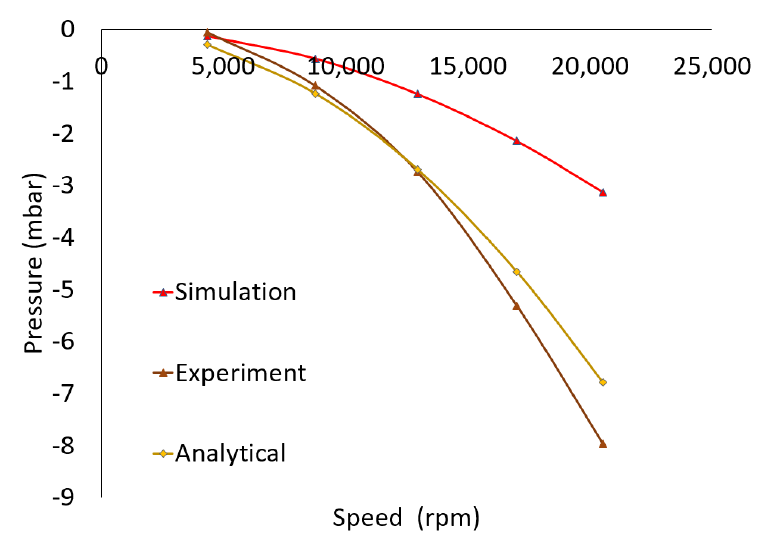
Figure 17. Pressure variation for 6 cm opening of the suction